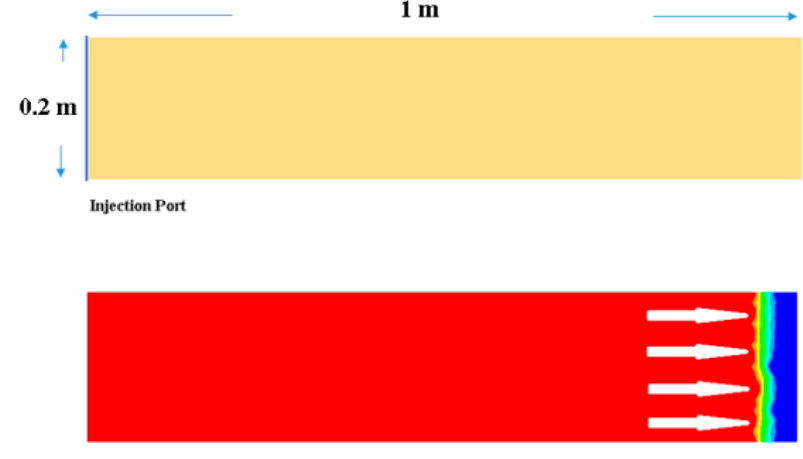
Figure 3. Analyzed case of unidirectional injection in a rectangular mold cavity: the flow advances from the left side (injection port) toward the right side (vent).